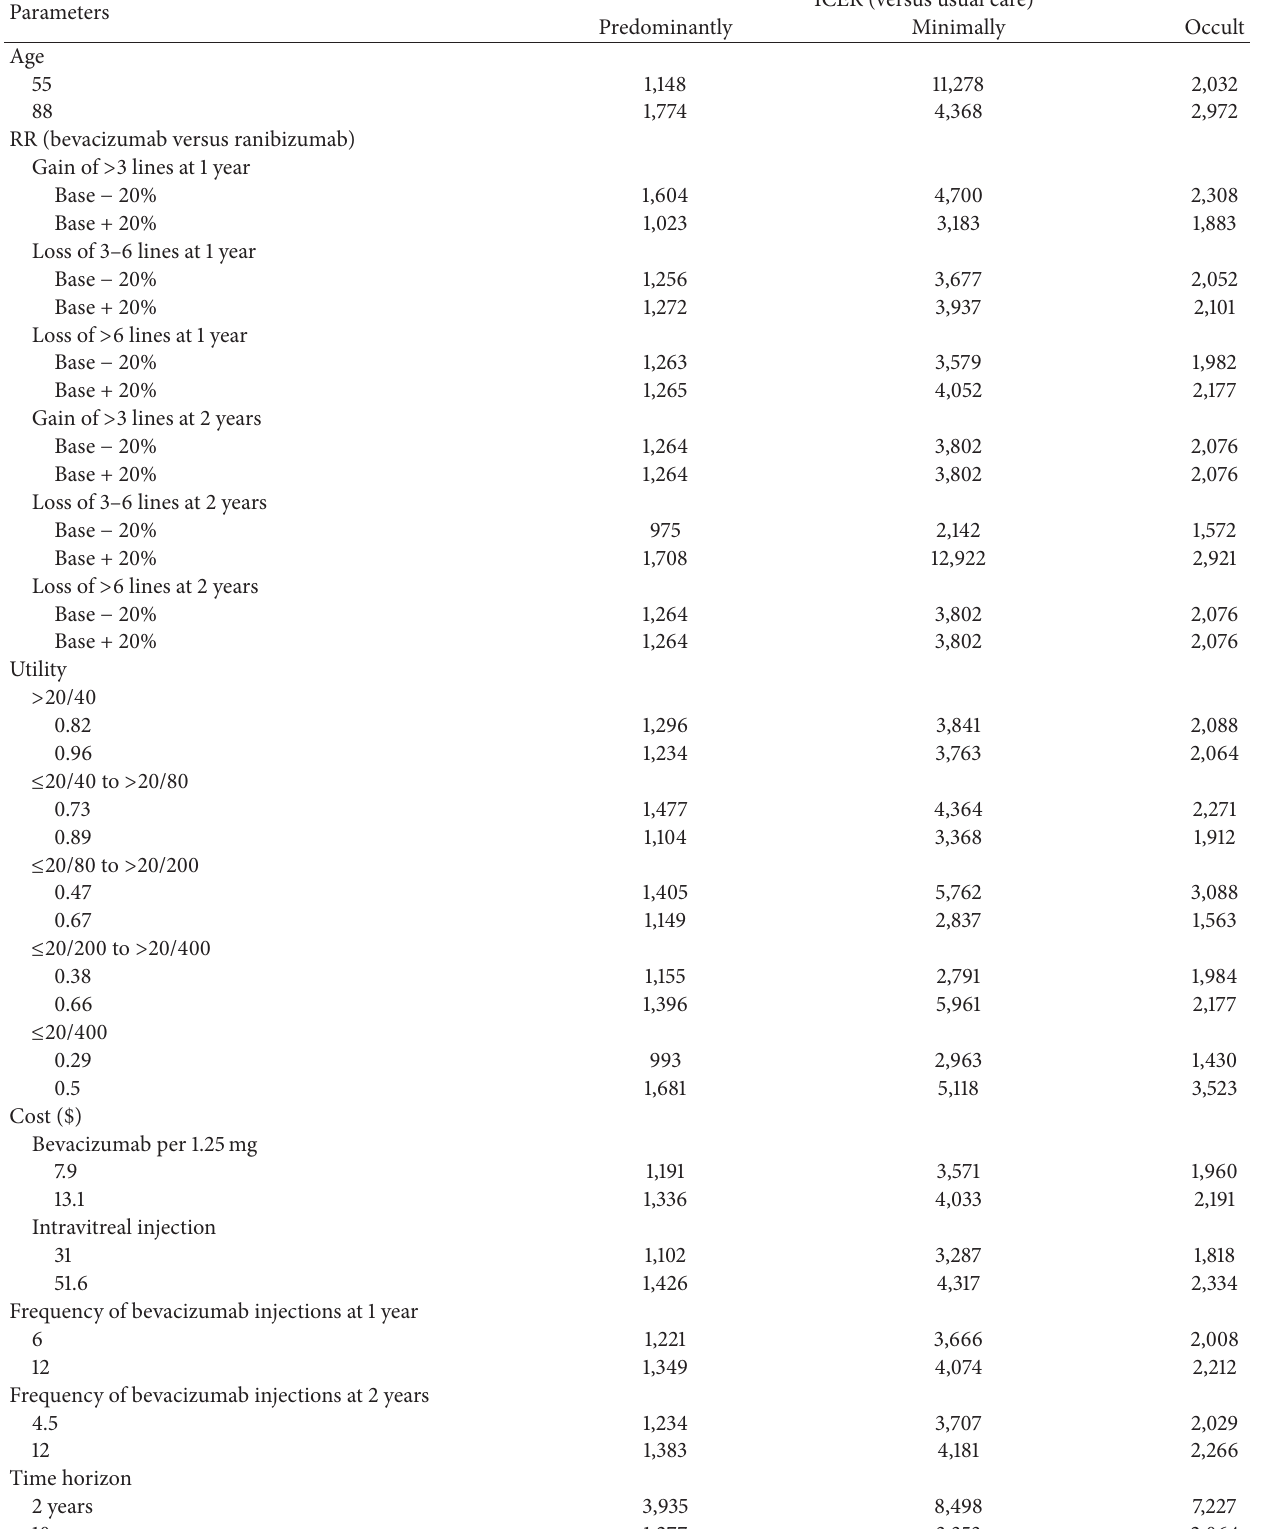
Table 5: One-way sensitivity results of